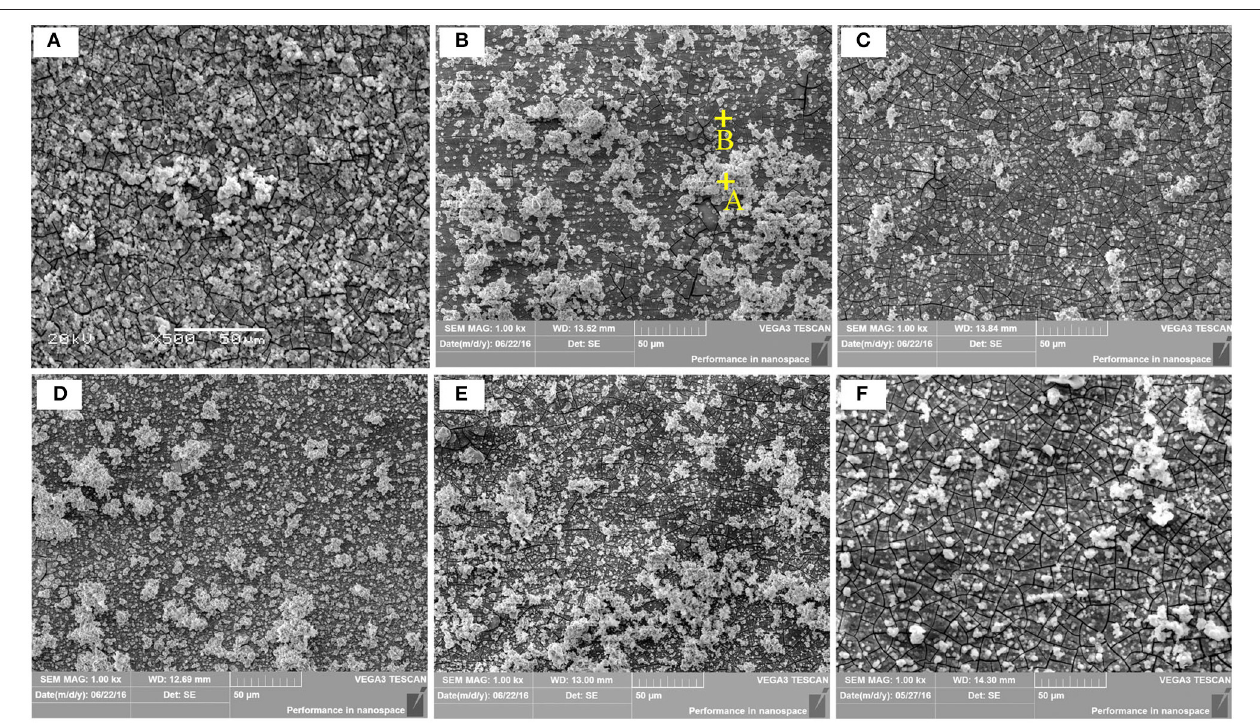
FIGURE 11 | Corrosion micrographs of the as-cast Mg-2.0Zn-0.5Zr-3.0Gd alloys after immersion in SBF for 120h. (A) As-cast; (B) E330; (C) E340; (D) E350; (E) E360; (F) E370.